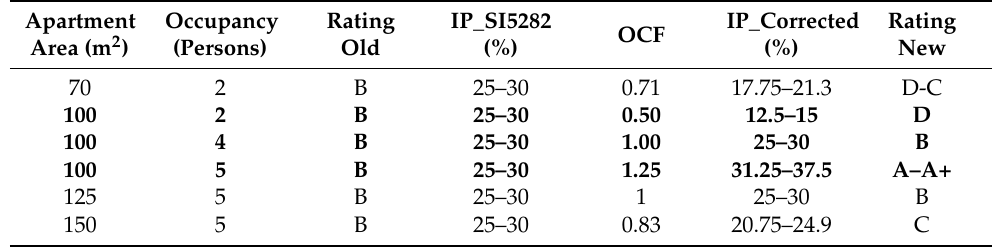
Figure 3. The Occupancy Correction Factor (OCF) as function of Floor Area and number of persons per household. The dotted line indicates SI5282. Table 3. Results of the application of OCF in rating apartments with different areas and occupancy rates, in Climate zone